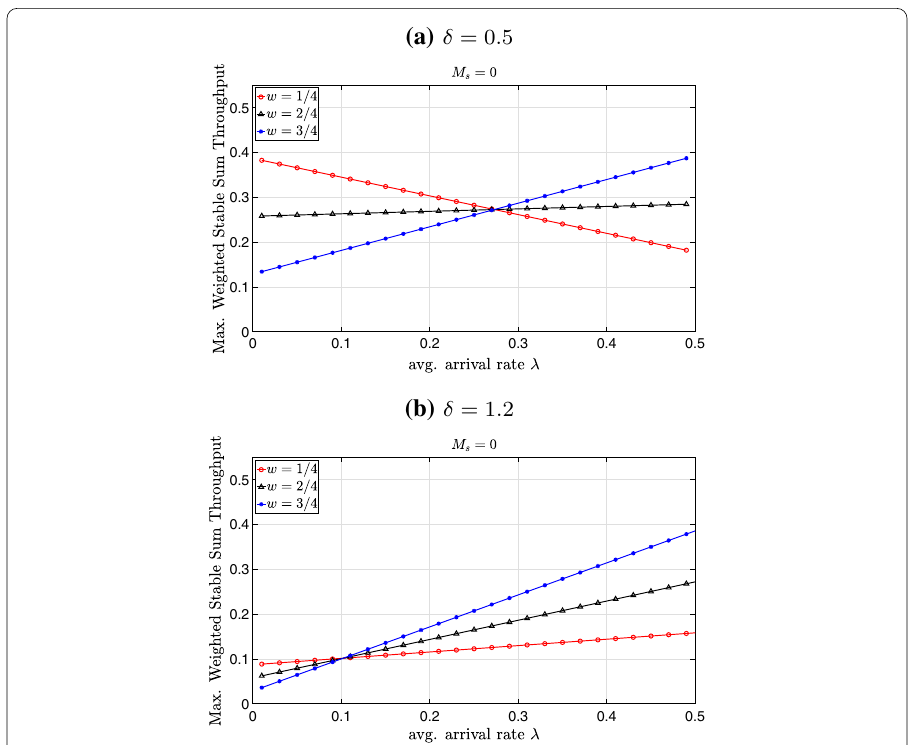
Fig. 9 The maximum weighted sum throughput vs. the average arrival rate (cid:31) for which the queue at S is stable, M U = 200, M D = 1000, M S = 0 and α = 0.7 using different values of w for: ( a ) δ = 0.5 and ( b ) δ = 1.2